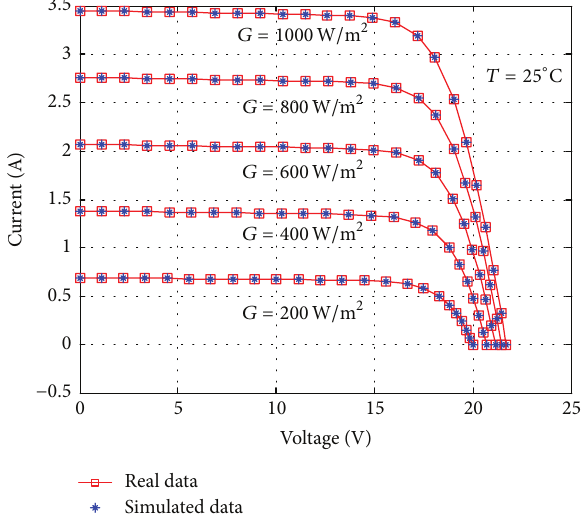
Figure 12: Comparison between real data and the simulated data by PCE for multicrystalline KC200GT at different